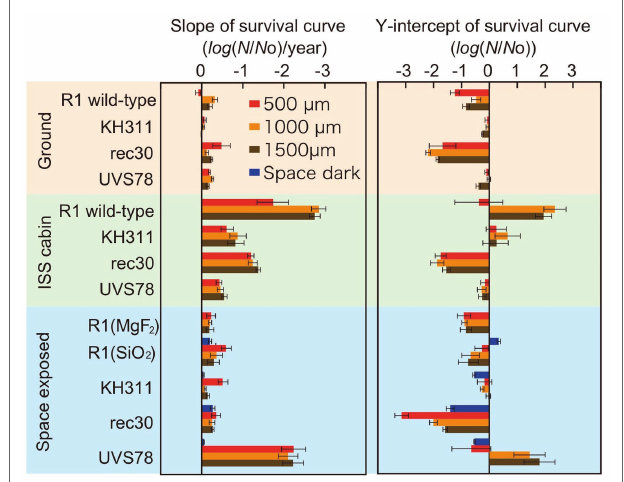
FIGURE 4 | Slope and Y-intercept of the survival curve of pellets of D. radiodurans wild type and DNA repair-deficient mutants at different thickness exposed to space from 1 to 3 years. Samples were either stored at the ground laboratory (top pale brown box) or ISS cabin (middle pale green box) or exposed to space (bottom pale blue box) under MgF 2 windows (UV >110 nm). D. radiodurans R1 was exposed also under SiO 2 windows (UV >170 nm) Red, orange and brown bars: 500-, 1,000-, and 1,500- μ m thick samples. Blue bars: exposed to the space environment without UV irradiation. Each error bar shows the SEM. See also Supplementary Tables 5 , 6 for the statistical analysis